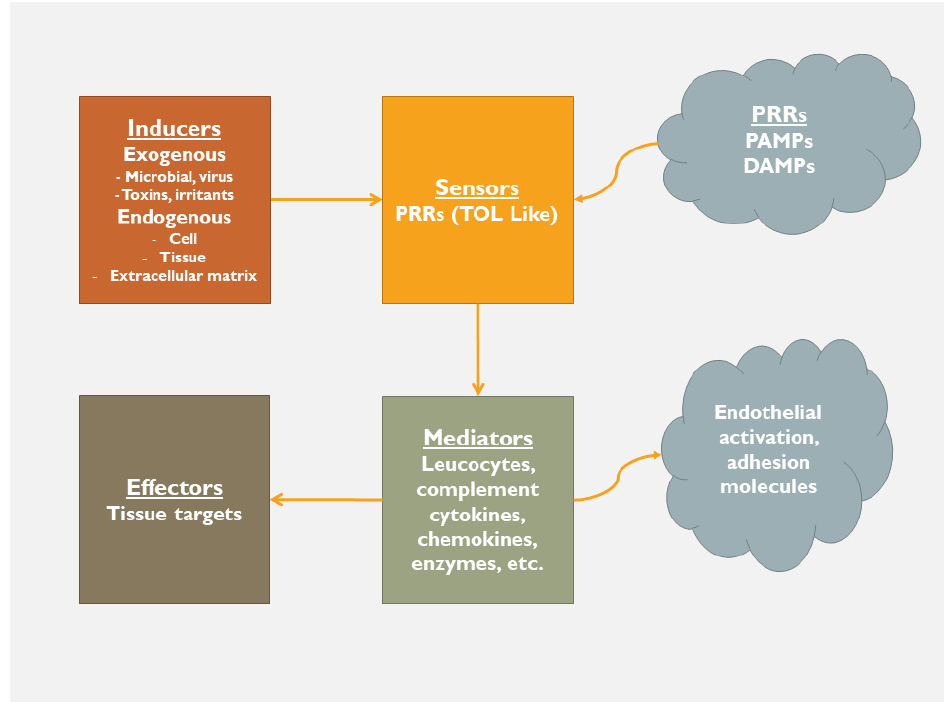
Figure 2. Mechanisms and mediators involved in the inflammatory process (PRRs—pattern recog- nition receptors; PAMPs—pathogen associated molecular patterns; DAMPs—damage-associated molecular patterns).